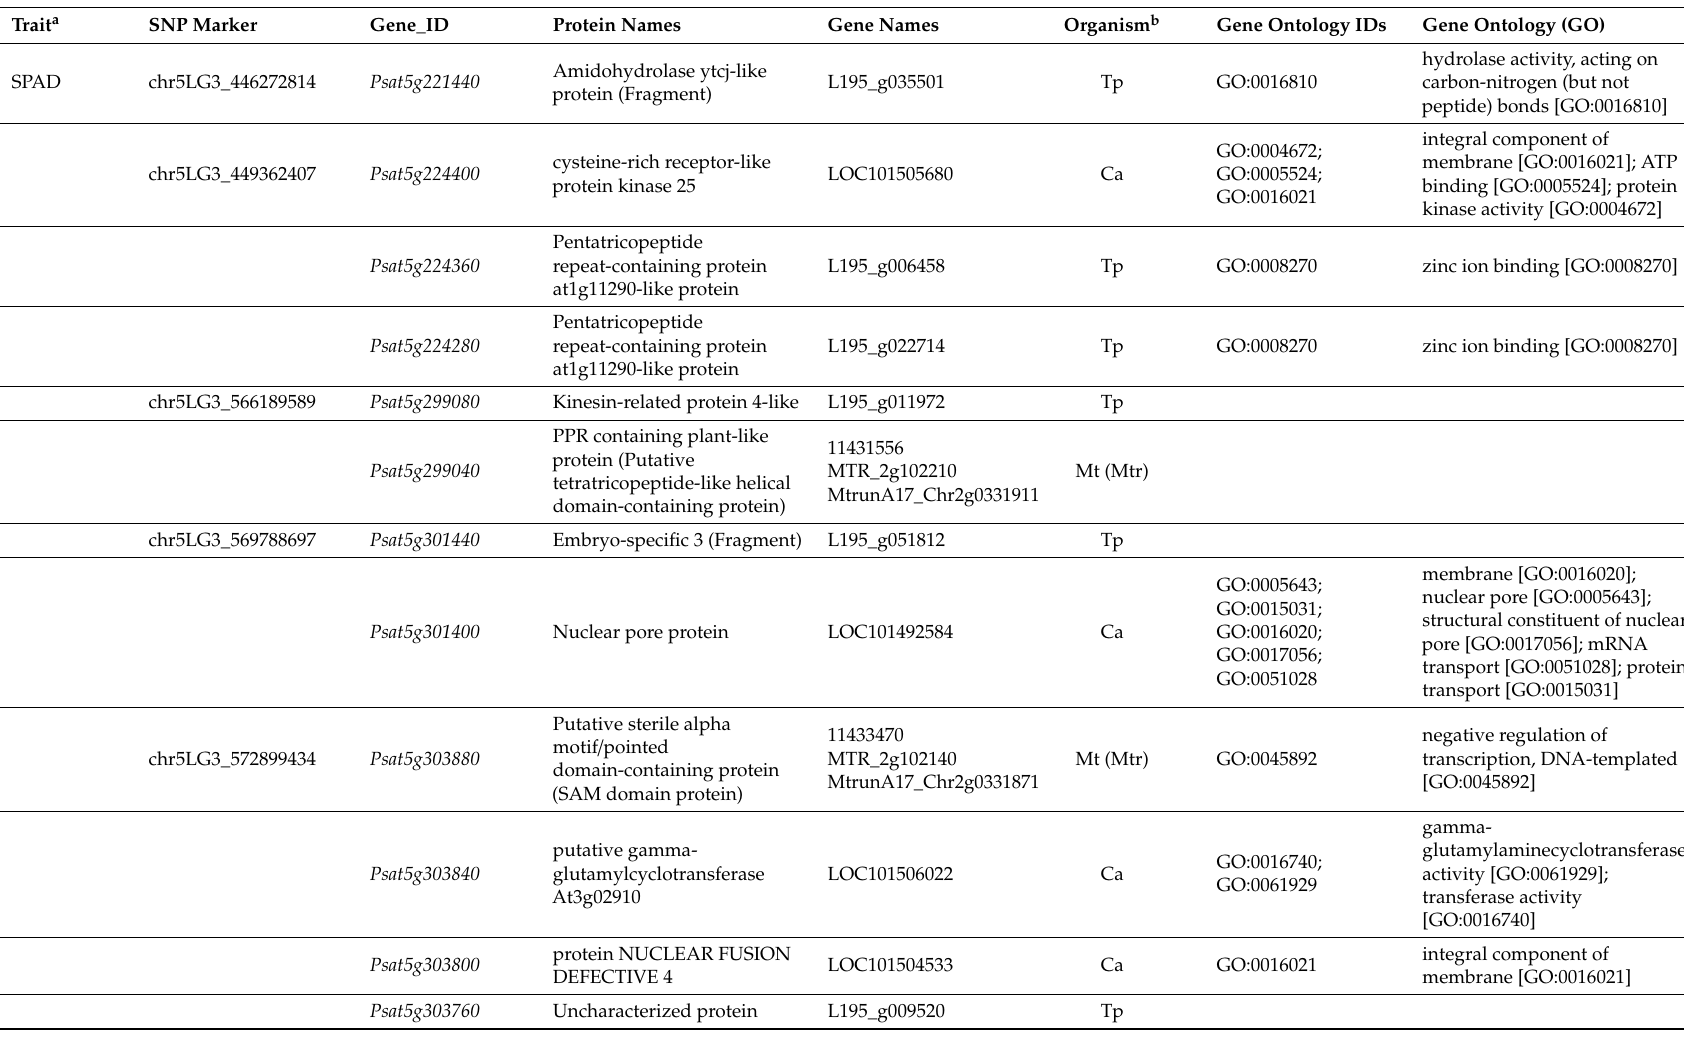
Table 5. Candidate genes identified within 15 kb distance of the SNP markers identified for association with the traits of heat tolerance. Trait